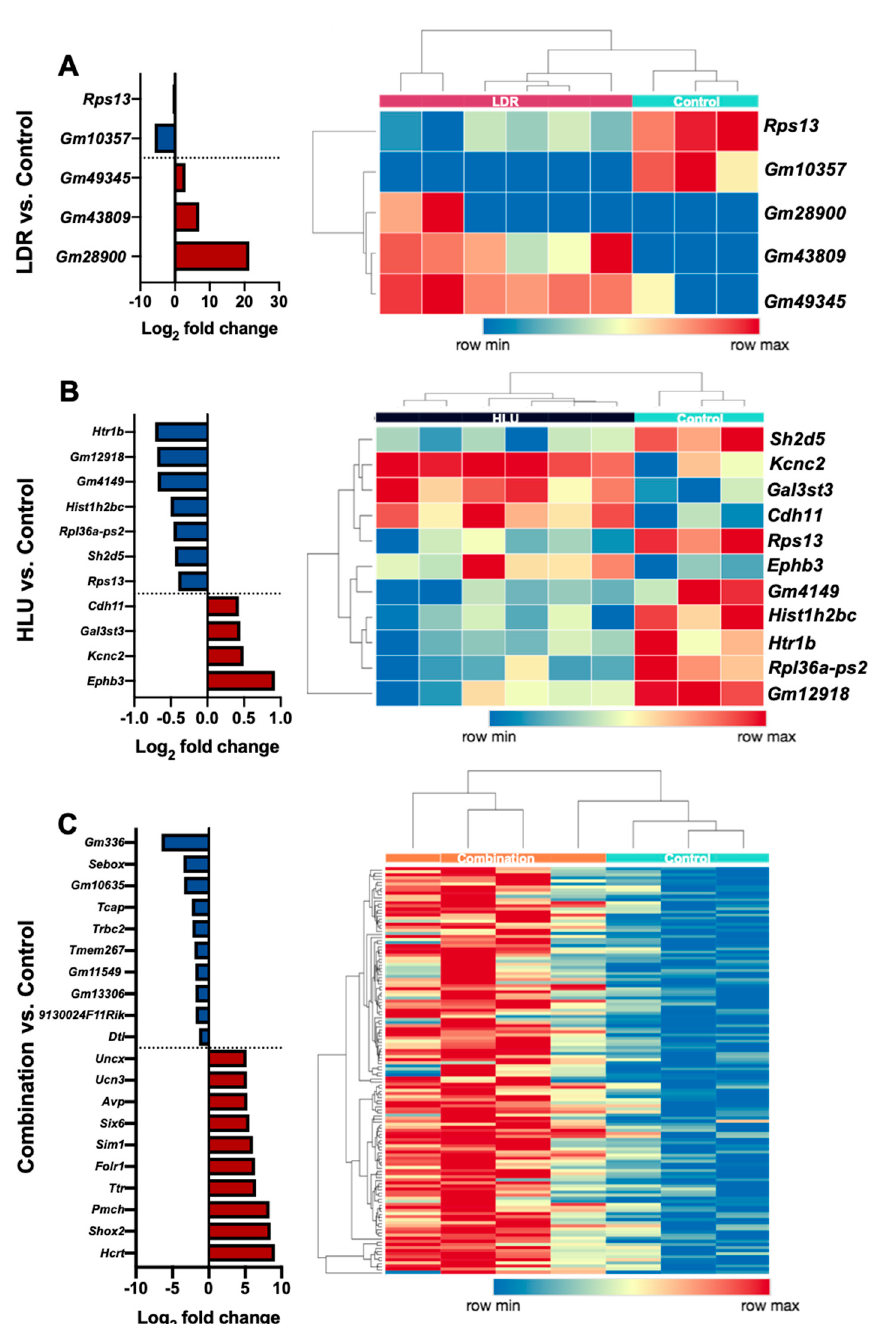
Figure 3. DEG profiles of brains isolated at 4 months post-HLU, LDR or combined HLU + LDR. ( A , left panel) Graph depicts LDR versus control samples Log 2 fold-change mean values ( n = 3–6); ( A , right panel) Heatmap displays individual DEG. ( B , left panel) Graph depicts HLU versus control samples Log 2 fold-change mean values ( n = 3–6); ( B , right panel) Heatmap displays individual DEG. ( C , left panel) Graph depicts a subset of the largest Log 2 fold-change gene set within combined HLU + LDR (combination) verses control samples Log 2 fold-change mean values ( n = 3–4); ( C , right panel) Heatmap displays individual DEG.